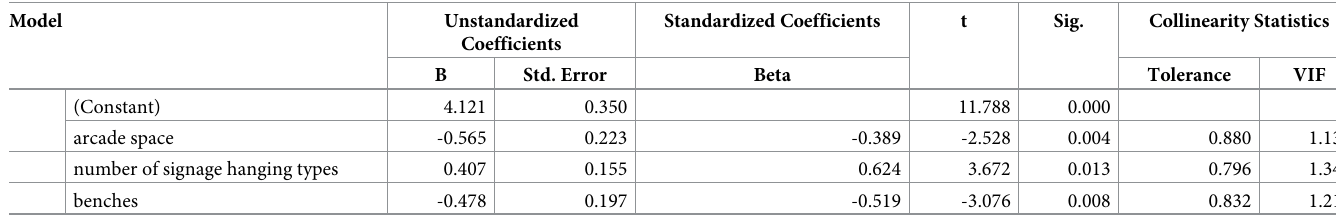
Table 4. Significant predictors (outdoor space characteristics) for 25 photos’ mean preference score of each participant emerging from the stepwise multiple linear regression analysis.